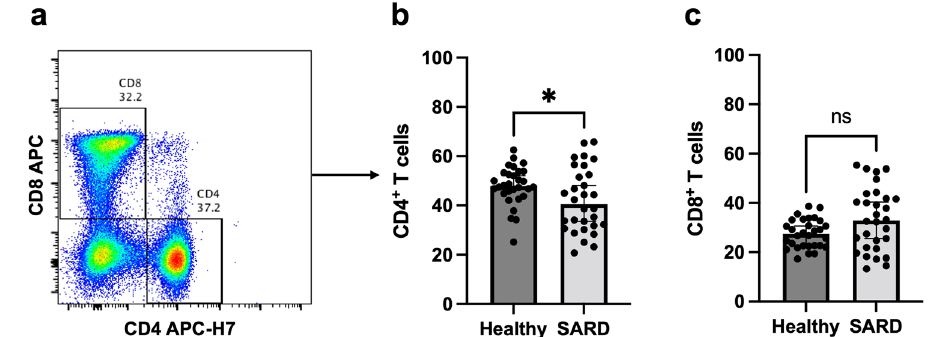
Fig. 3 T cell responses in patients with systemic autoimmune rheumatic diseases and healthy group. Patients with SARDs and the healthy group were vaccinated with CoronaVac followed by ChAdOx1 nCoV-19 (Oxford-AstraZeneca). After 4 weeks, blood samples were obtained and processed to obtain PBMCs. Frozen PBMCs were thawed and stimulated with S1 peptide pools. The cells were stained and analyzed using fl ow cytometry. ( a ) Representative fl ow plot showing CD8 + and CD4 + T cell populations were gated. ( b ) Percentage of CD4 + T cells and ( c ) CD8 + T cells following vaccination. Each symbol represents one participant and data are presented as the median with 95% CI. Statistical signi fi cance was determined using the Mann – Whitney test between groups. * p ≤ 0.05, ns nonsigni fi